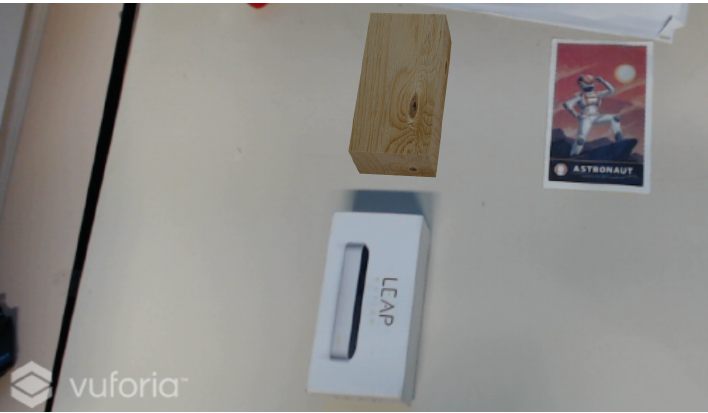
Figure 23. Comparison between Real and Not Shadowed Object.